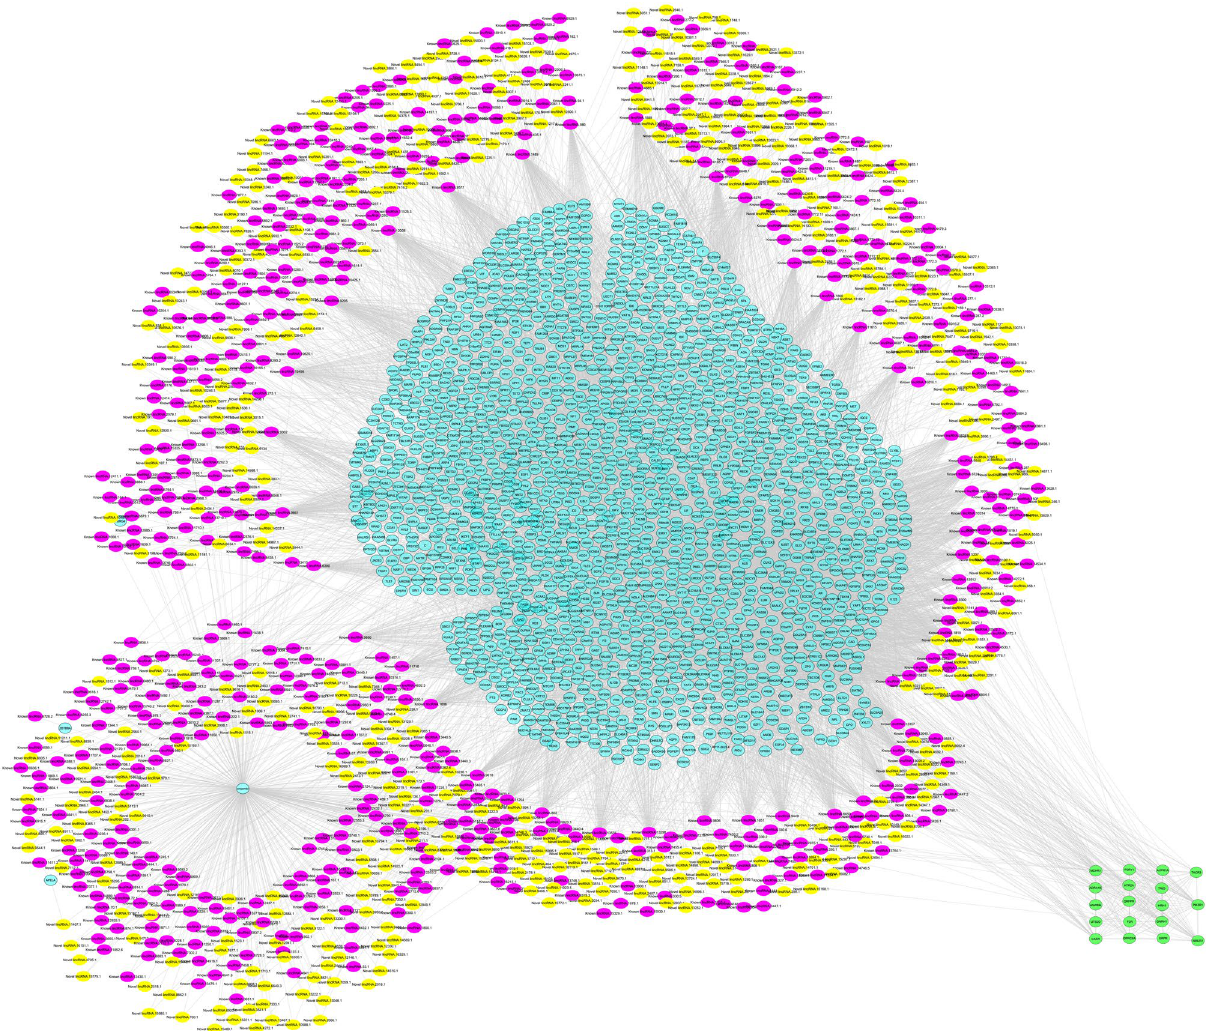
Figure 6. Final constructed network based on the known and novel lincRNAs. Purple nodes: Known lincRNAs, yellow nodes: Novel lincRNAs, Sky blue nodes: protein coding genes, green nodes: predicted module (P-value =